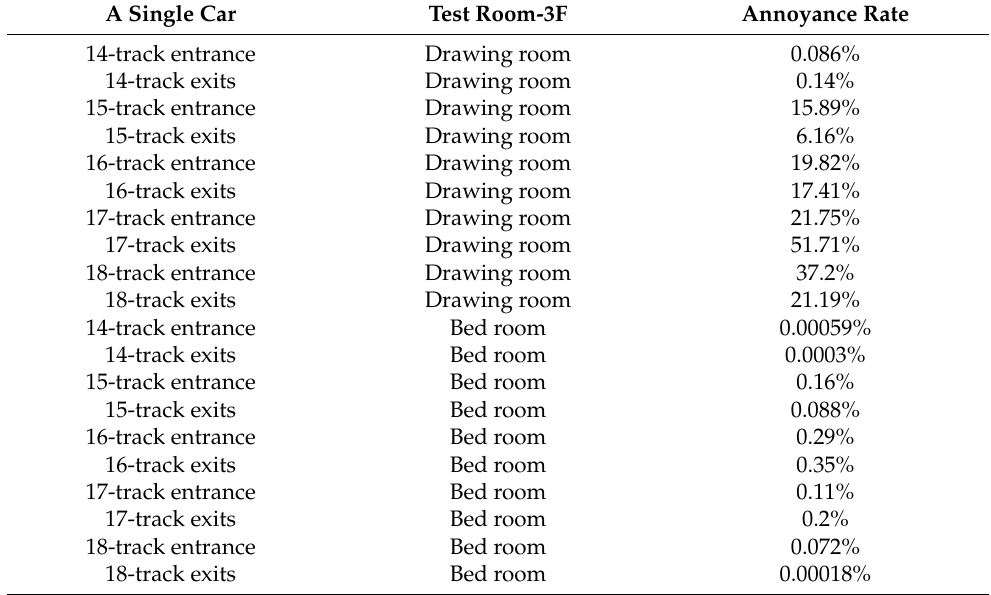
Table 12. Vibration annoyance rate of the third-floor test room during a single-train operation based on annoyance rate model.